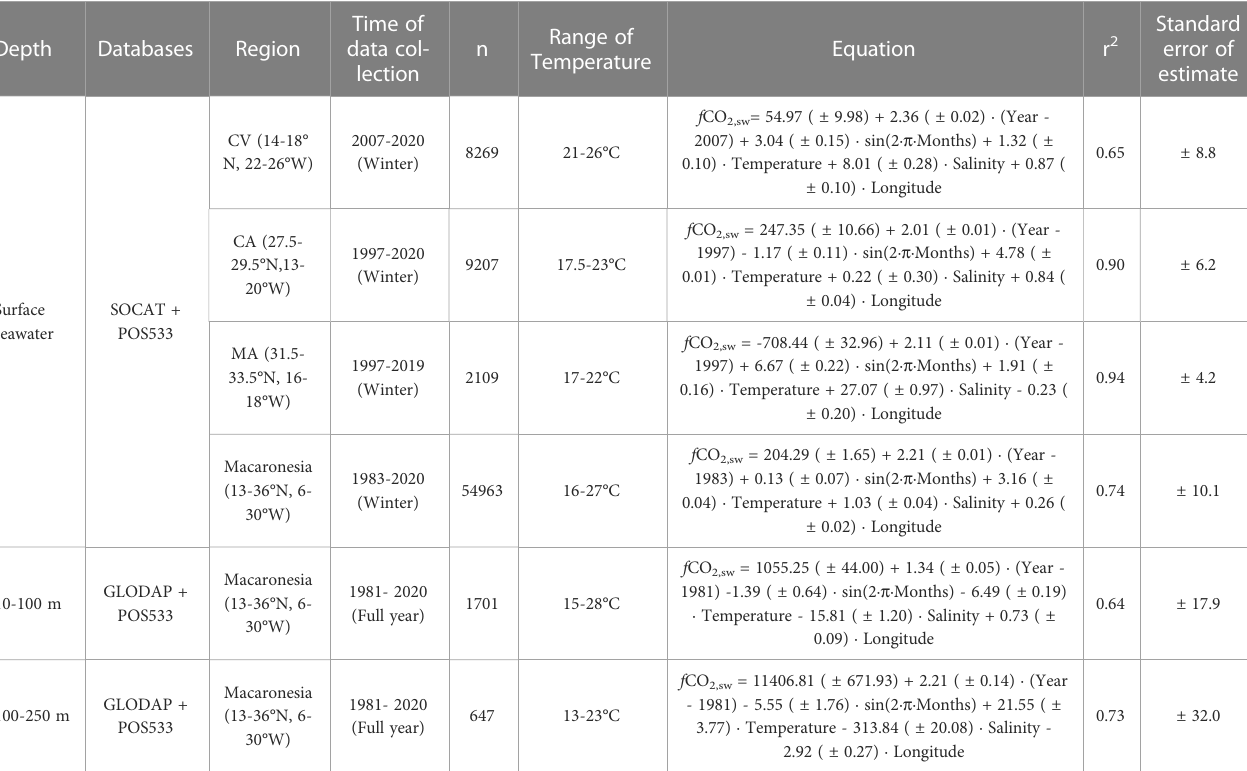
TABLE 2 Set of multiparametric regressions which described the spatio-temporal changes in upper ocean f CO 2,sw based on fl uctuations of the physical properties.